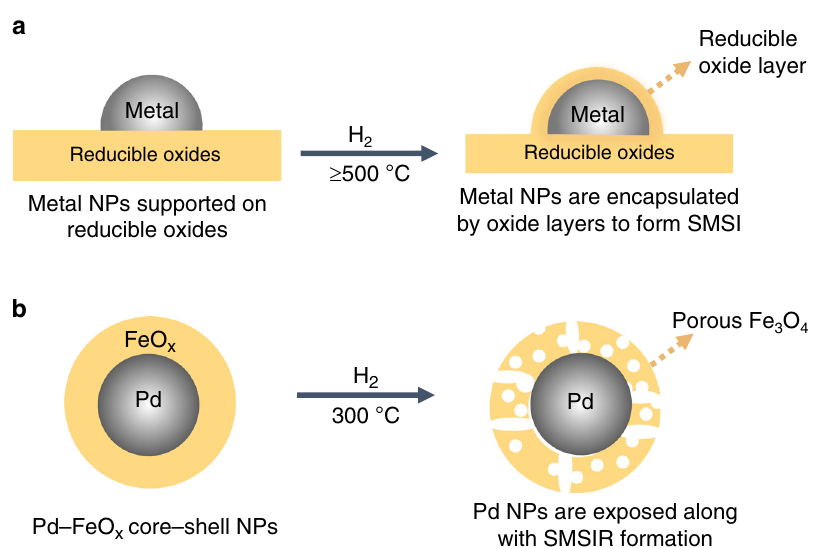
Fig. 1 Schematic illustration of the formation of strong interactions. a The conventional SMSI formation process. b The SMSIR formation process in this